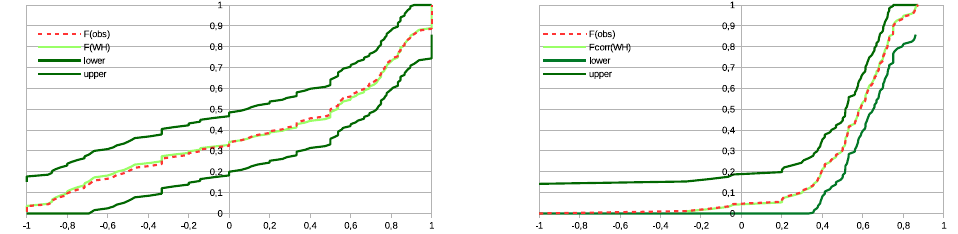
Figure 2. Cumulative frequency distribution (green) approximated with Equation (A5) with κ = 0.7700 and δ = 0.7548 ( θ KS = 0.0156) for school year 1950/51 (left) and κ = 0.4500 and δ = 0.5500 for 1989/90 ( θ KS = 0.0073) (right) with 80 per cent conficence bands (dark green) around the observed cumulative frequency distribution (light